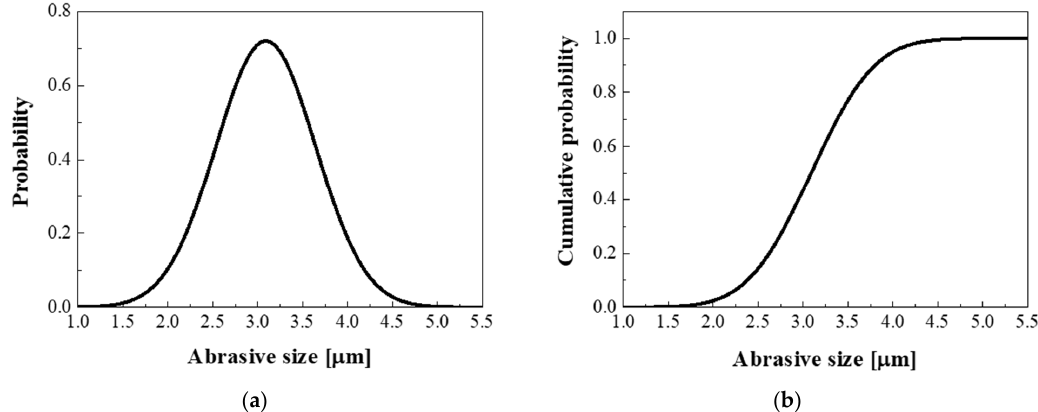
Figure 13. ( a ) Normal distribution of abrasive size; ( b ) cumulative distribution of abrasive size.